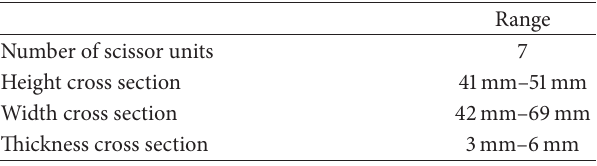
Table 3: Range of design variables of the Pareto